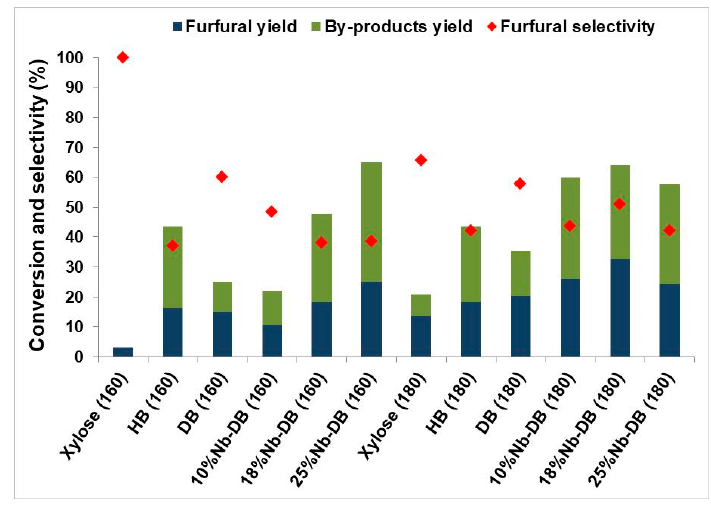
Figure 8. Conversion (%) of xylose and selectivity (%) for furfural.